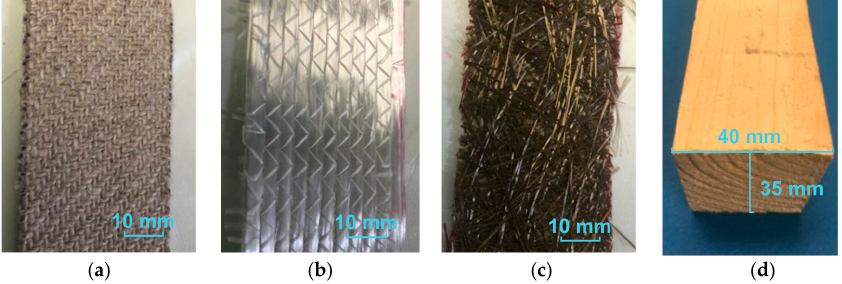
Figure 1. Photos of testing materials: ( a ) flax fabric, ( b ) glass fabric, ( c ) basalt mat and ( d ) wood beam.